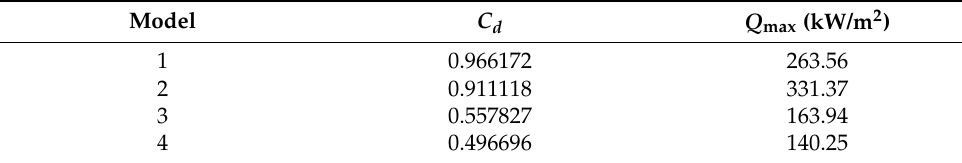
Figure 10. Initial pressure and heat flux of forebody: ( a ) pressure; ( b ) heat flux.